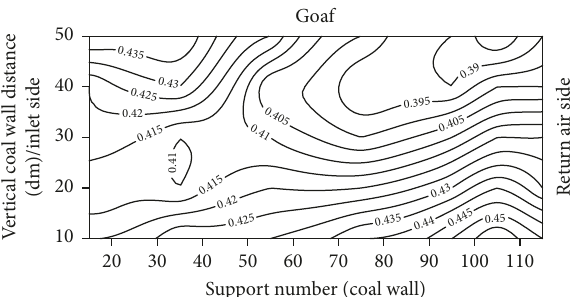
Figure 6: Isograms of gas volume fraction along the air direction in the working face.